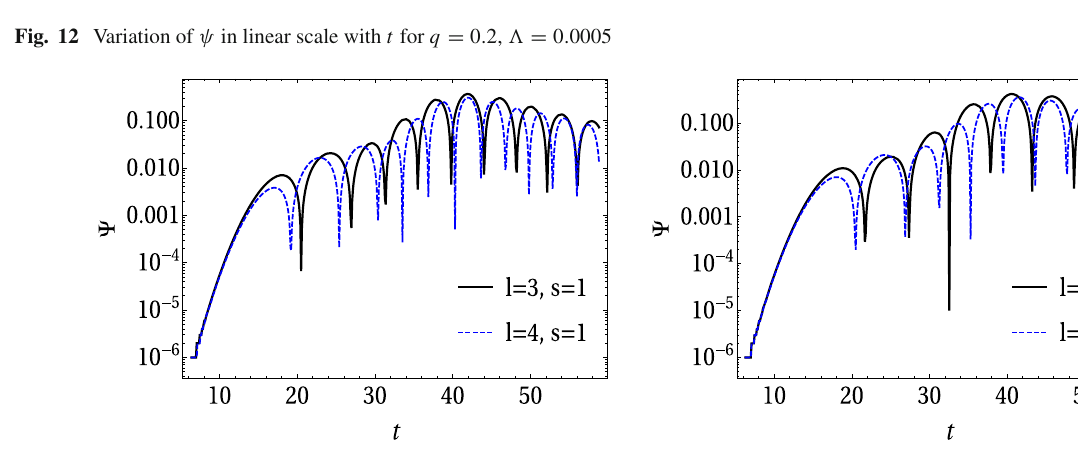
Fig. 13 Variation of ψ in log scale with t for q = 0 . 2 and (cid:2) = 0 . 0005